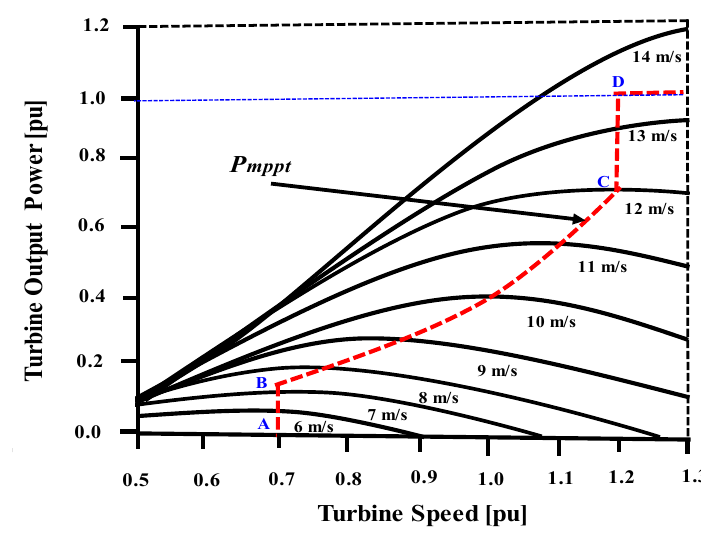
Figure 4. Wind turbine characteristics for the doubly fed induction generator (DFIG) with maximum power point tracking (MPPT).